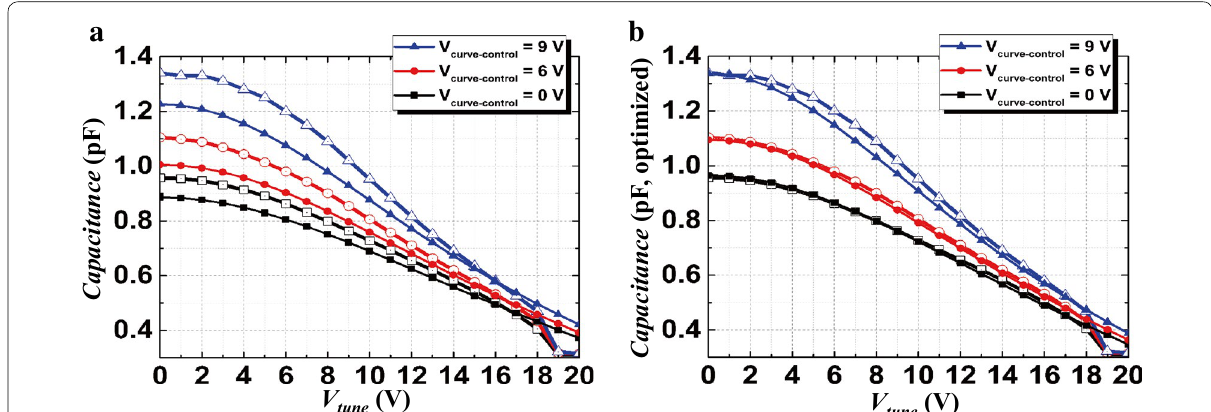
Fig. 11 Comparison of the calculated and measured C–V response of the proposed capacitor. a Pure comparison. b Modified comparison result including optimization factor (parasitic